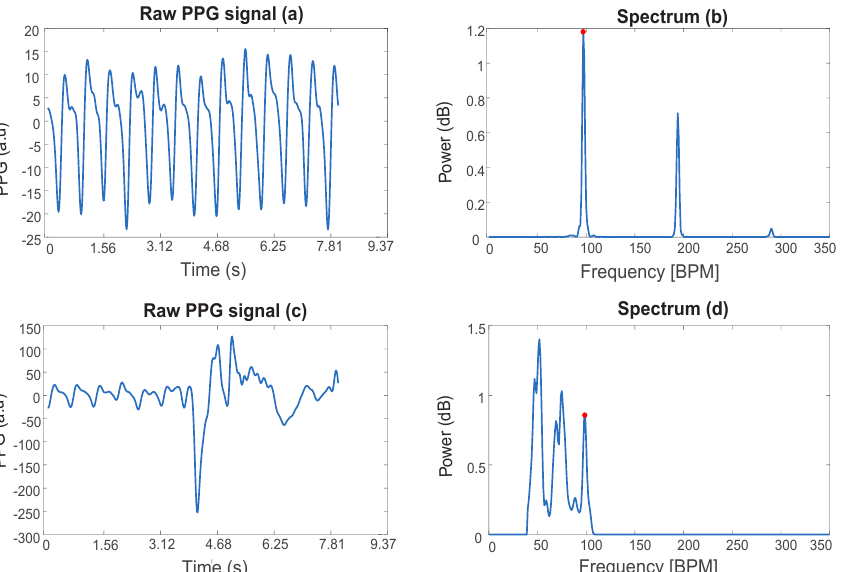
Figure 1. Photoplethysmographic (PPG) signals and corresponding spectra. ( a , c ) represent a PPG signal of a subject at rest and performing physical exercises with MA, respectively. ( b , d ) show the corresponding single-sided amplitude spectrum. The spectral peak that corresponds to the cardiac rhythm is marked with a red